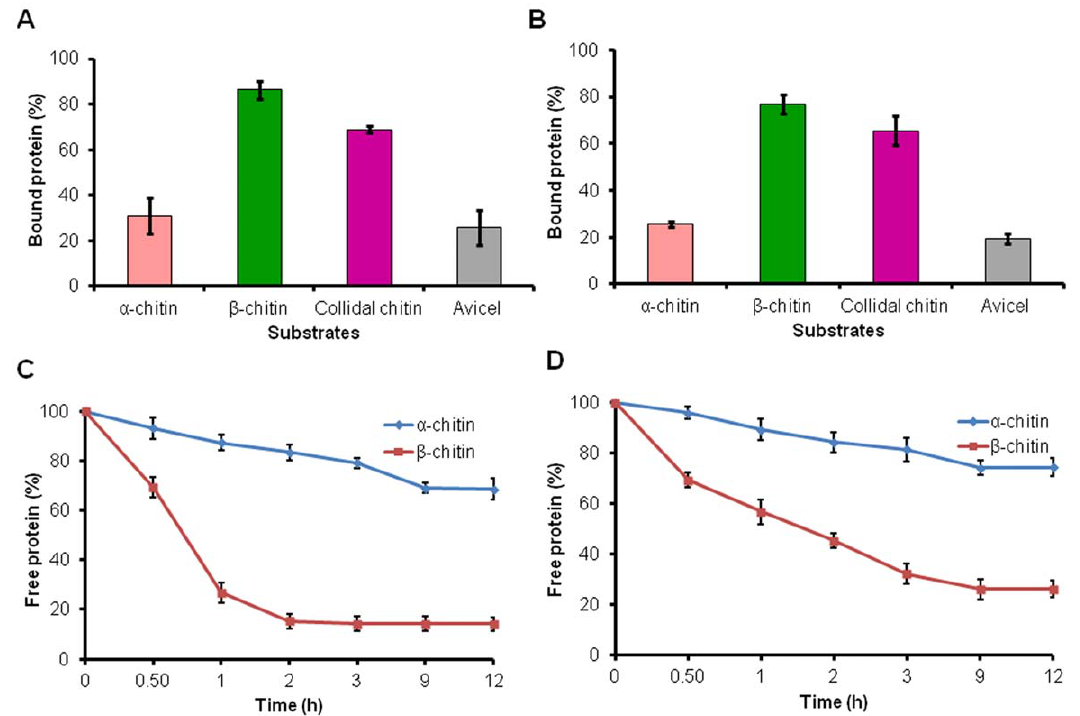
Figure 1. Binding of Sp CBPs to insoluble polymeric substrates. The reaction mixture (1 mL) containing 100 m g of Sp CBP21/ Sp CBP50 and 1 mg of one of the insoluble substrates ( a -chitin, b -chitin, colloidal chitin and Avicel) was incubated in 50 mM sodium phosphate buffer pH 7.0 under constant shaking at 1300 rpm at 37 u C for 24 h. (A and B) The amount of bound protein was calculated as the difference in protein concentration before and after incubation with the insoluble substrates, (C and D) Decrease in free protein concentration after binding to a - and b -chitin was determined at different time points till 24 h. (A and C) Sp CBP21, (B and D) Sp CBP50. Vertical bars represent standard deviation of triplicate